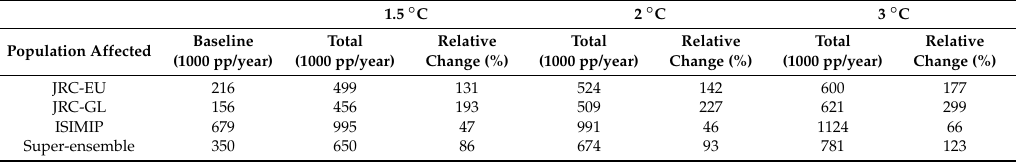
Table 3. Population affected from the three case studies (ensemble average) and at SWLs, including relative change. Averages of the three ensembles are included in the last